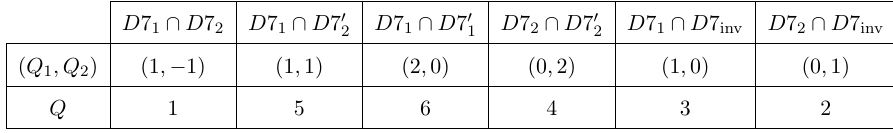
Table 8 . U(1) charges for the charge 6